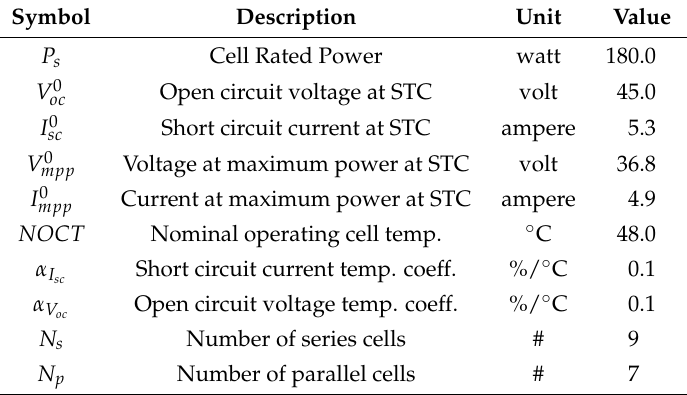
Table 2. PV parameters used for the example of Section 4 with the model form and parameter definitions of Vergura et al. [31], where STC is the abbreviation for Standard Test Conditions. The parameters are for a single module with multiple cells arranged in parallel and series as per the appropriate parameters. Symbol Description Unit Value P s Cell Rated Power watt 180.0 V 0 oc Open circuit voltage at STC volt 45.0 I 0 sc Short circuit current at STC ampere 5.3 V 0 mpp Voltage at maximum power at STC volt 36.8 I 0 mpp Current at maximum power at STC ampere 4.9 NOCT Nominal operating cell temp. ◦ C 48.0 α I Short circuit current temp. coeff. %/ ◦ C 0.1 sc α V Open circuit voltage temp. coeff. %/ ◦ C 0.1 oc N s Number of series cells N p Number of parallel